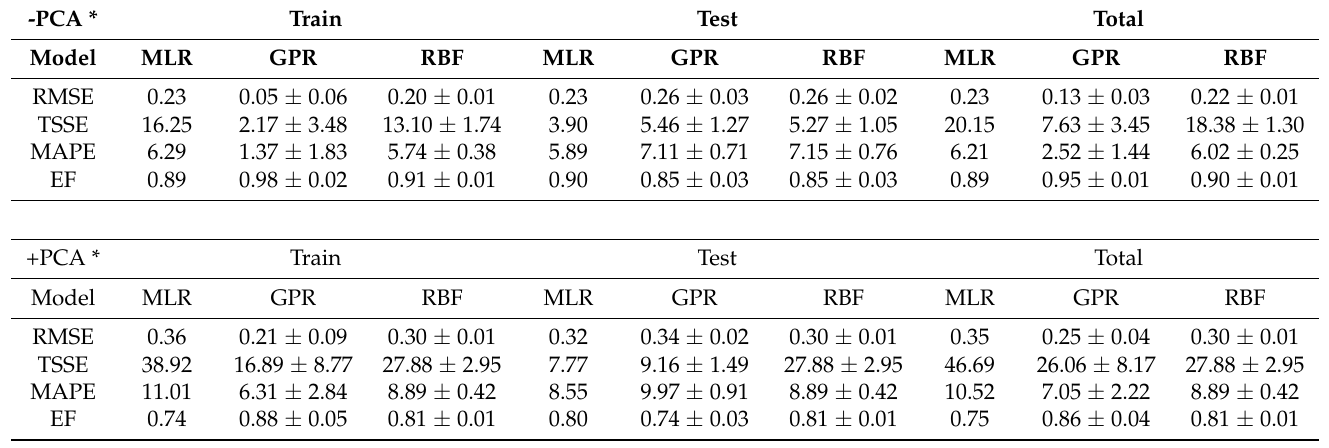
Table 8. MLR, GPR, and RBF model assessments based on initial and PCA-derived input